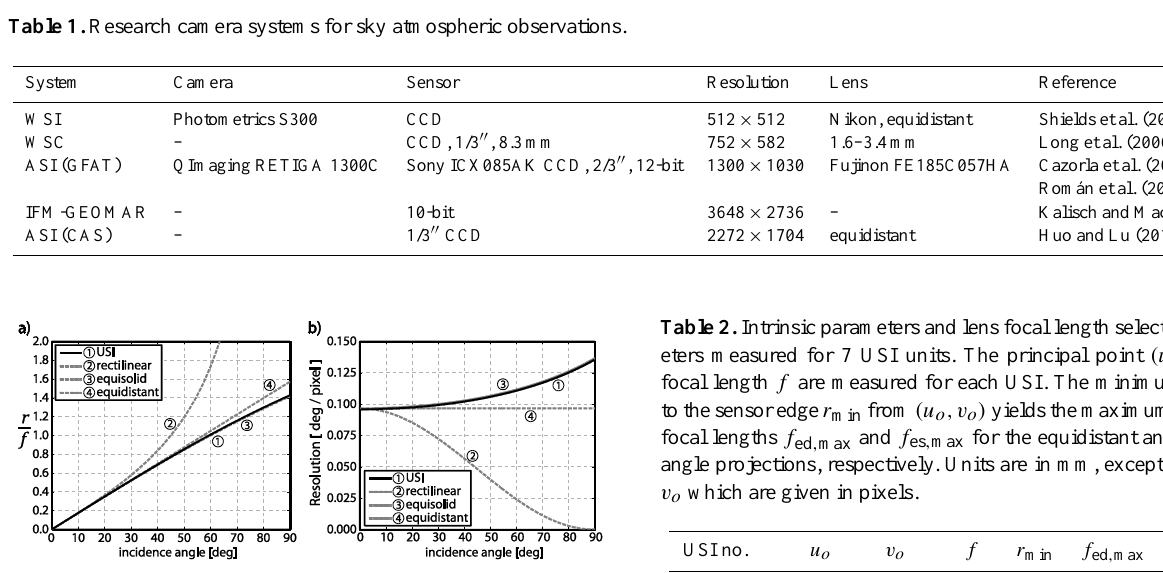
Figure 2. (a) Perspective (rectilinear), equidistant, and equisolid an- Fig. 2. (a) Perspective (rectilinear), equidistant, and equisolid angle projection 3 gle projection distances as a function of incidence angle, along with distances as a function of incidence angle, along with the projection for USI 1.2 4 the projection for USI 1.2 determined from geometric calibration. determined from geometric calibration. The projection distance is normalized by the 5 The projection distance is normalized by the focal length. (b) Zenith focal length. (b) Zenith angle resolution of projections in (a). 6 angle resolution of projections in (a) .